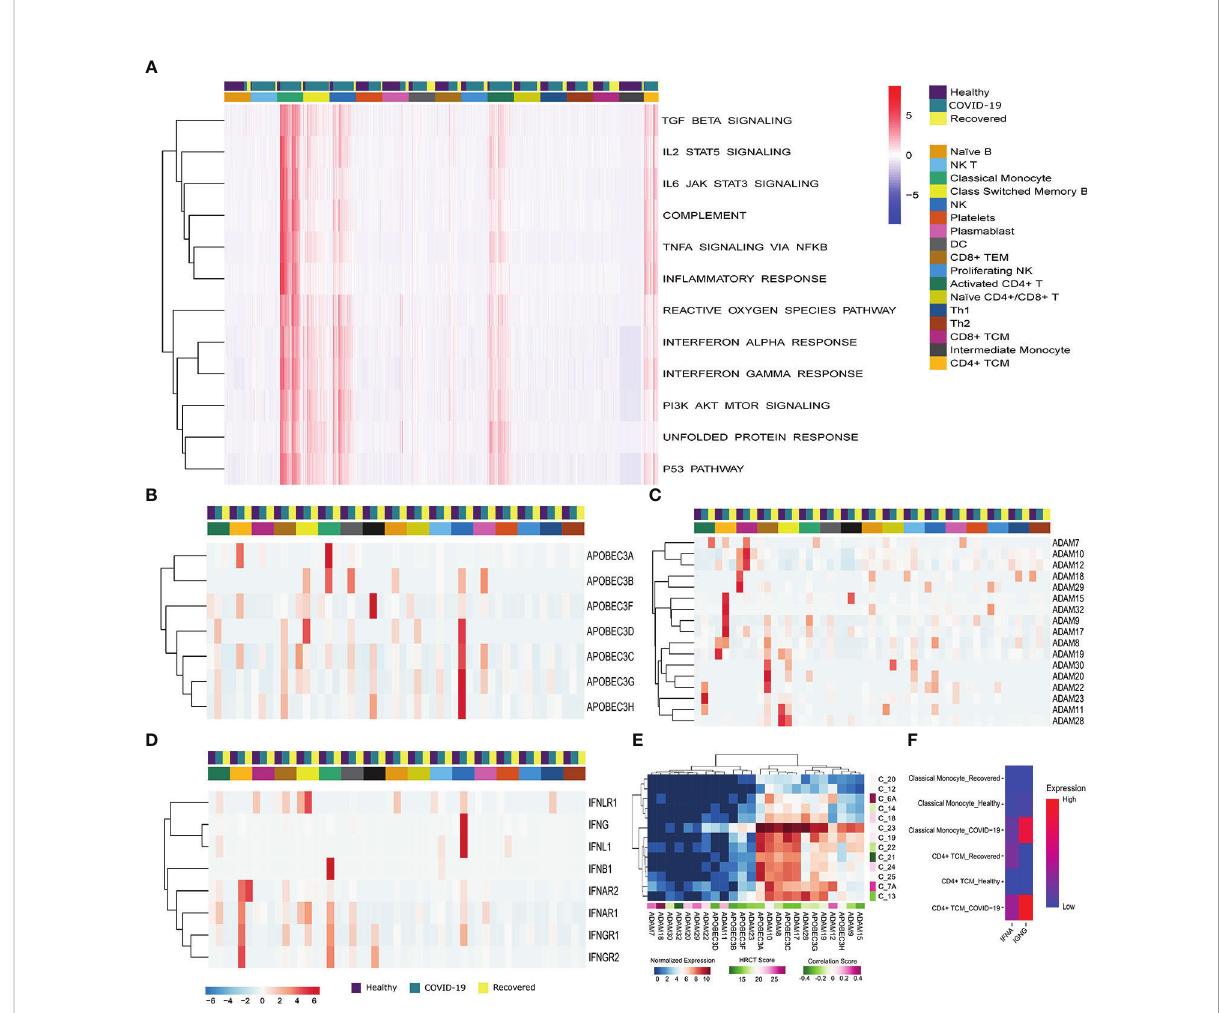
FIGURE 3 Immune, stress and antiviral Response during the SARS-CoV-2 infection. (A) G SEA at the single cell resolution across the three groups (COVID-19 patients, healthy and recovered), the row dendrograms distinguish the immune and stress response pathways. The cell types and the groups were highlighted using different color bars. Data is expressed as a relative enrichment score for each pathway. (B, C) Expression of (B) ADAM , and (C) APOBEC3 genes. (D) Expression of antiviral genes in the COVID-19 patients and correlation with HRCT score. (E) Expression of IFN family genes across all the cell types across the three groups. Cell types and groups were highlighted using different color bars. (F) Cumulative expression of type I and type II IFN receptors between the Classical monocyte and CD4+ TCM across the three